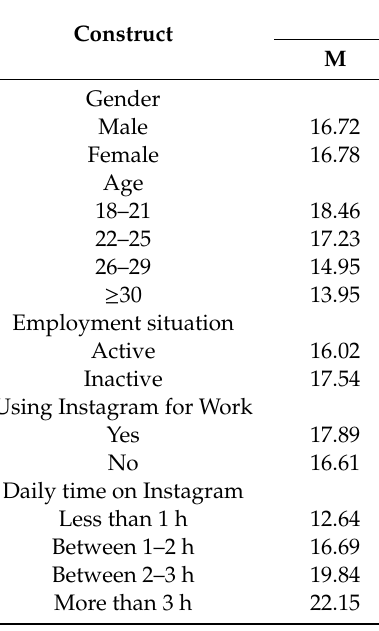
Figure 1. Typology of image publication on Instagram. Table 2. Descriptive statistical values and significance for each scale based on socio-demographic